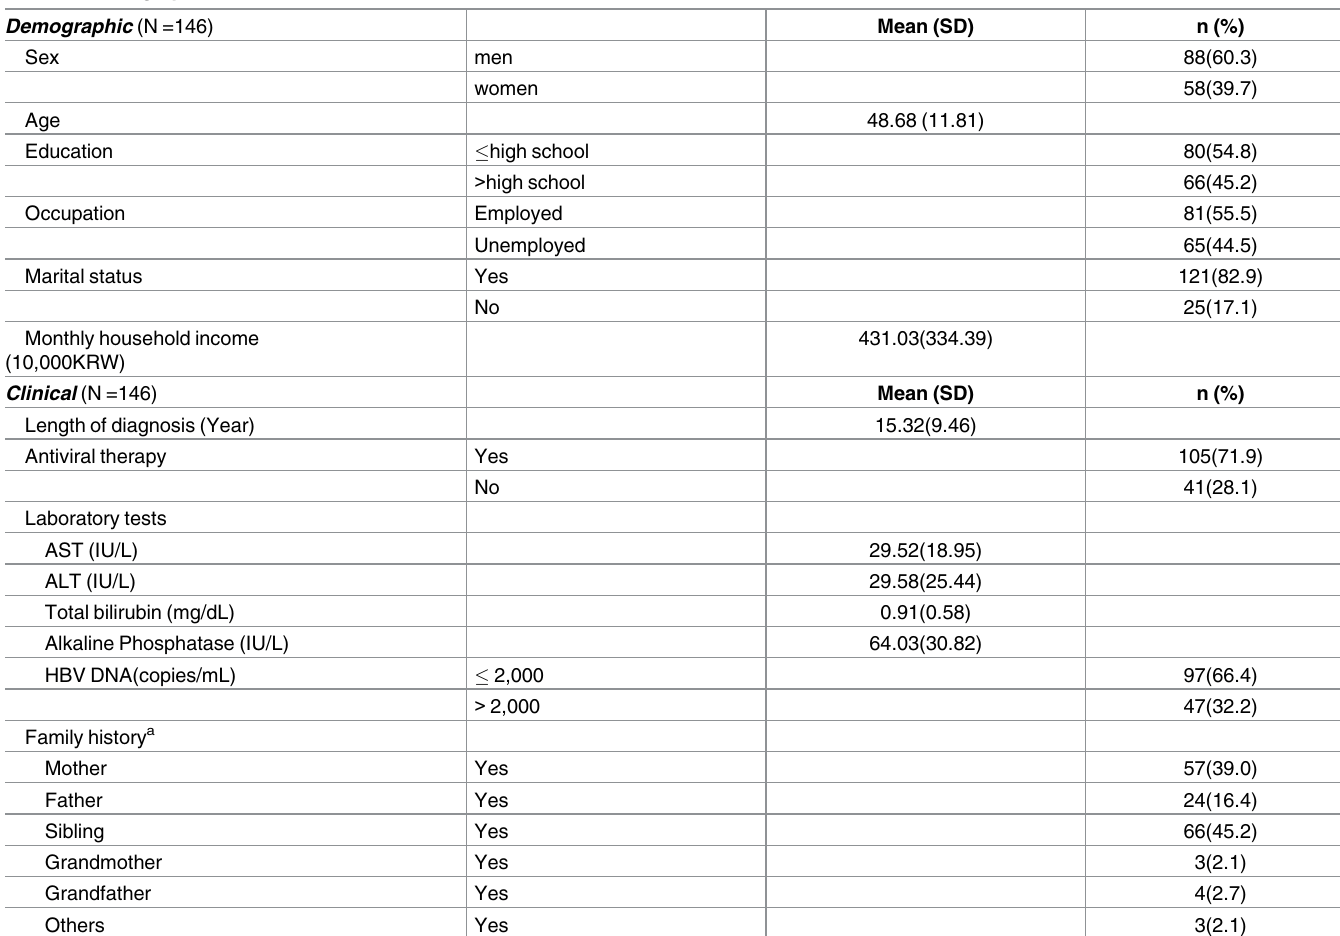
Table 1. Demographic & clinical